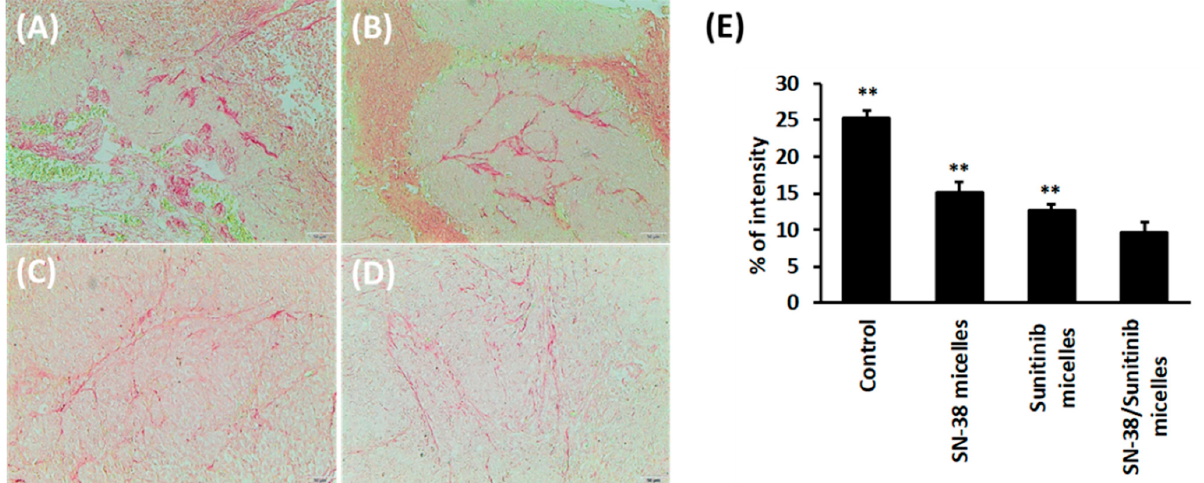
Figure 9. Tumor-associated fibrosis of HCT-116 tumors from mice at 28 days after treatment com- prising control-normal saline ( A ), SN-38 micelles ( B ), Sunitinib micelles ( C ), and SN-38/Sunitinib micelles ( D ) (200× magnification) by Sirius red staining and quantification percentage of intensity ( E ). Data represent mean ± standard deviation. ** means significantly different at p < 0.01, compared with SN-38/Sunitinib micelles.